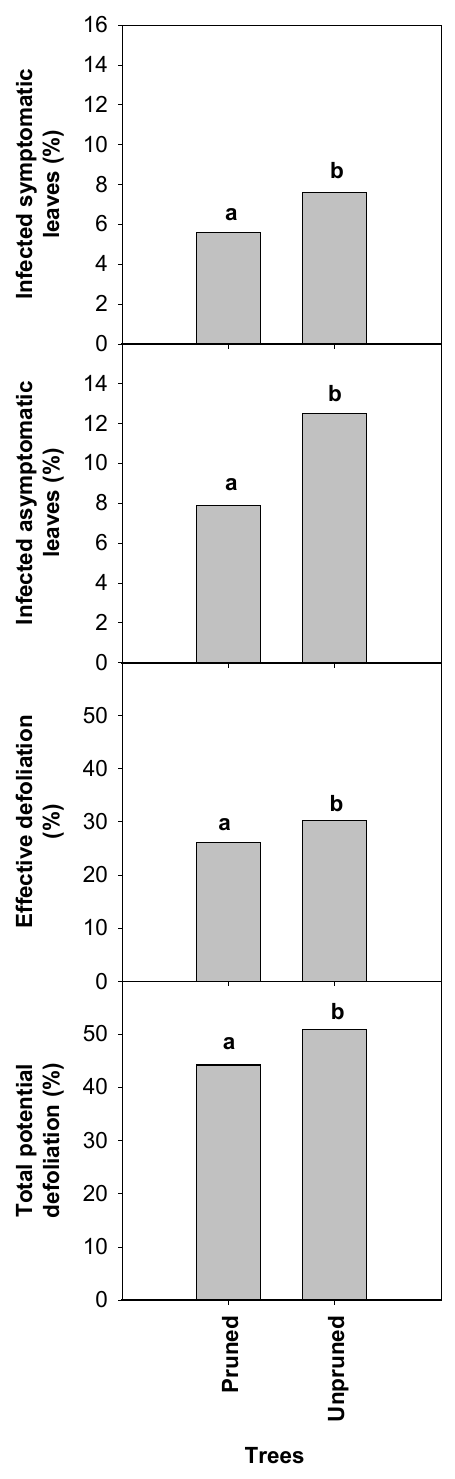
Figure 4. Means of olive tree defoliation and Venturia oleaginea infections as influenced by three different tree canopy positions (upper, middle and lower). Means accompanied by the same letter are not significantly different ( P ≤